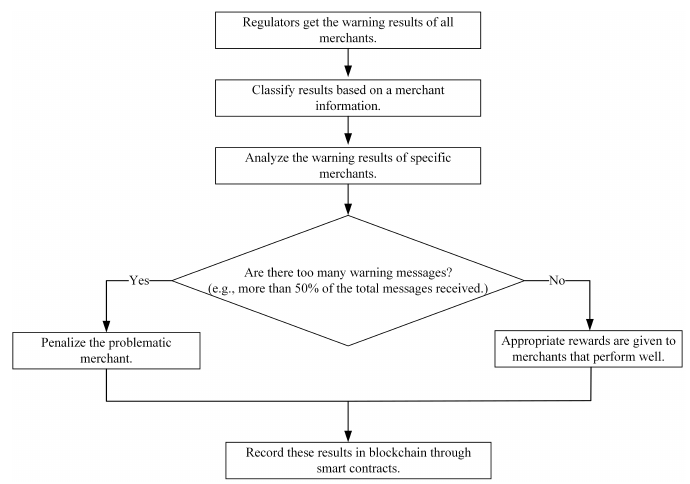
Figure 5. The regulation process for problematic